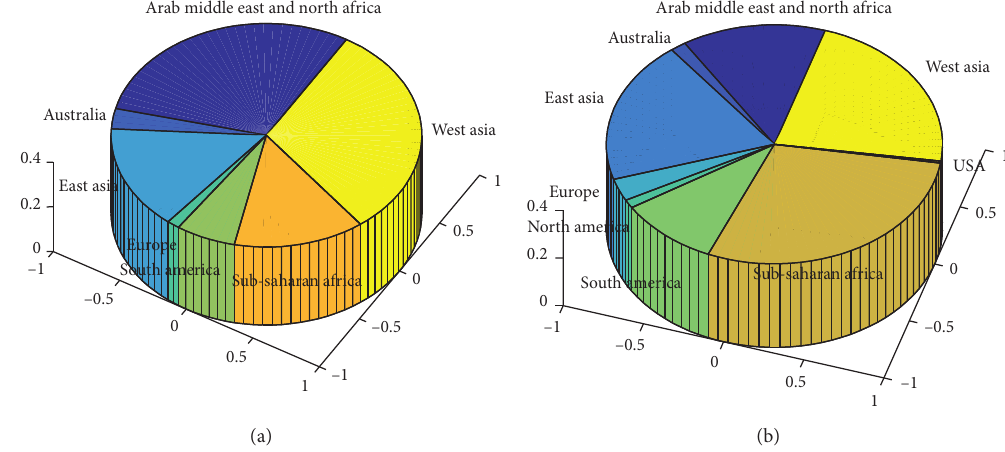
Figure 10: Regions of China’s overseas construction projects (No. 2): (a) 2005–2007; (b) 2015–2017.